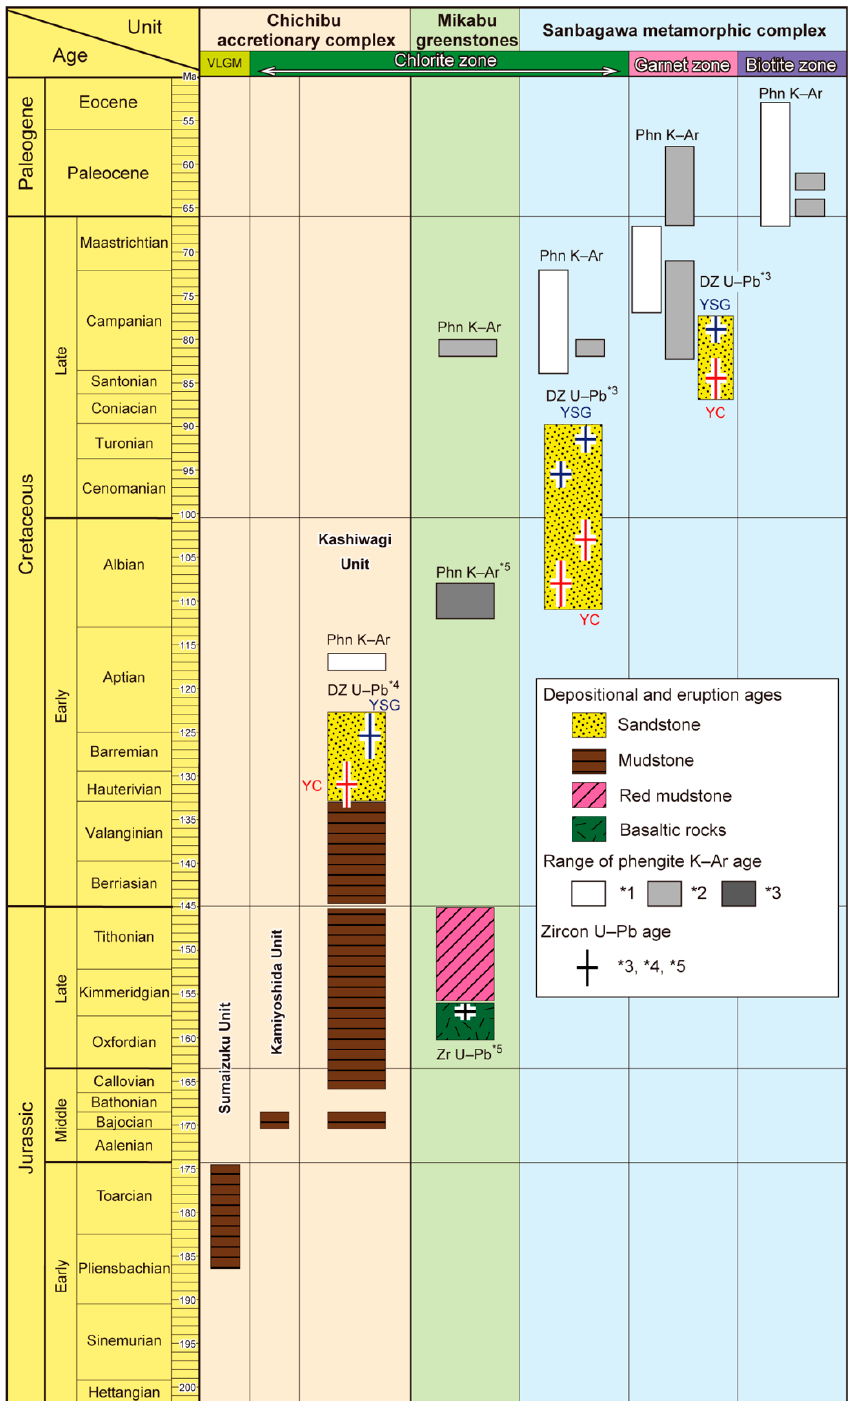
Figure 2. Stratigraphic summary of the Sanbagawa metamorphic complex, the Mikabu greenstones, and the Chichibu accretionary complex in the Kanto Mountains showing the phengite K–Ar ages (Phn K–Ar), zircon U–Pb ages (Zr U–Pb), detrital zircon U–Pb ages (DZ U–Pb), youngest single grain detrital zircon ages (YSG, blue crosses), and youngest cluster of detrital zircon ages (YG, red crosses). VLGM: very low-grade metamorphism. Data sources: Hirajima et al. [18] (*1); Miyashita and Itaya [19] (*2); Tsutsumi et al. [20] (*3); Tominaga et al. [21] (*4); and Tominaga and Hara [13] (*5). The Chichibu accretionary complex in the study area is divided into three tectono- stratigraphic units: Kashiwagi, Kamiyoshida, and Sumaizuku in ascending